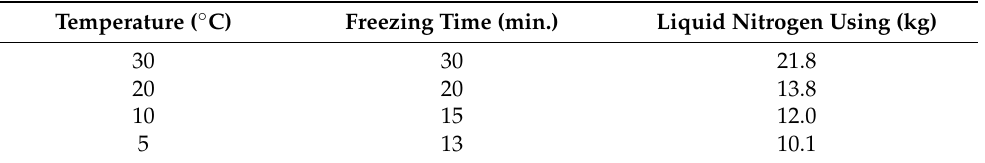
Table 2. Freezing time for different water temperatures inside the pipe. Temperature ( ◦ C) Freezing Time